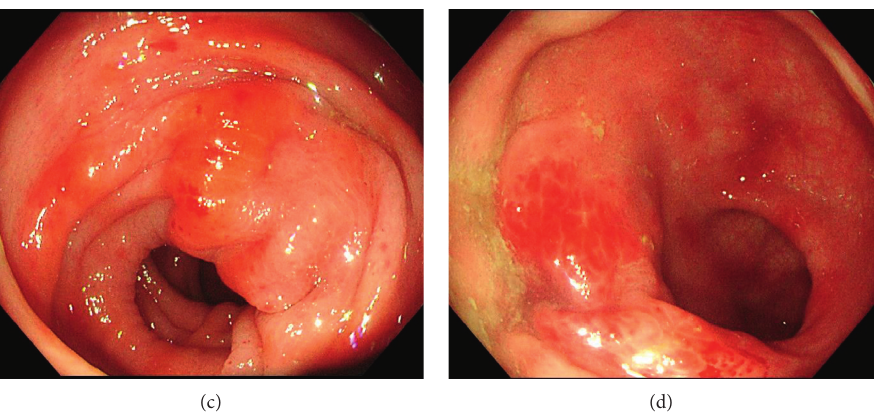
Figure 3: Findings of colonoscopy: (a) descending colon, (b and c) sigmoid colon, (d) rectum. Colonoscopy showed erythema and moderate edema in the entire colon and multiple submucosal tumor-like wall thickenings in the left-sided colon and the